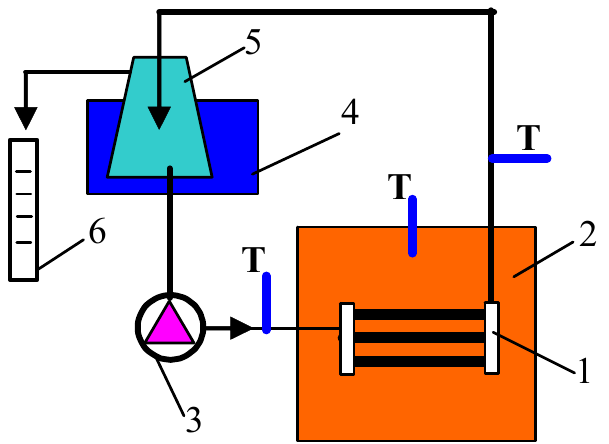
Figure 1. Experimental Membrane Distillation (MD) set-up. 1—MD module, 2—feed tank with electrical heating, 3—peristaltic pump, 4—cooling bath, 5—distillate tank, 6—measurement cylinder, T—thermometer.